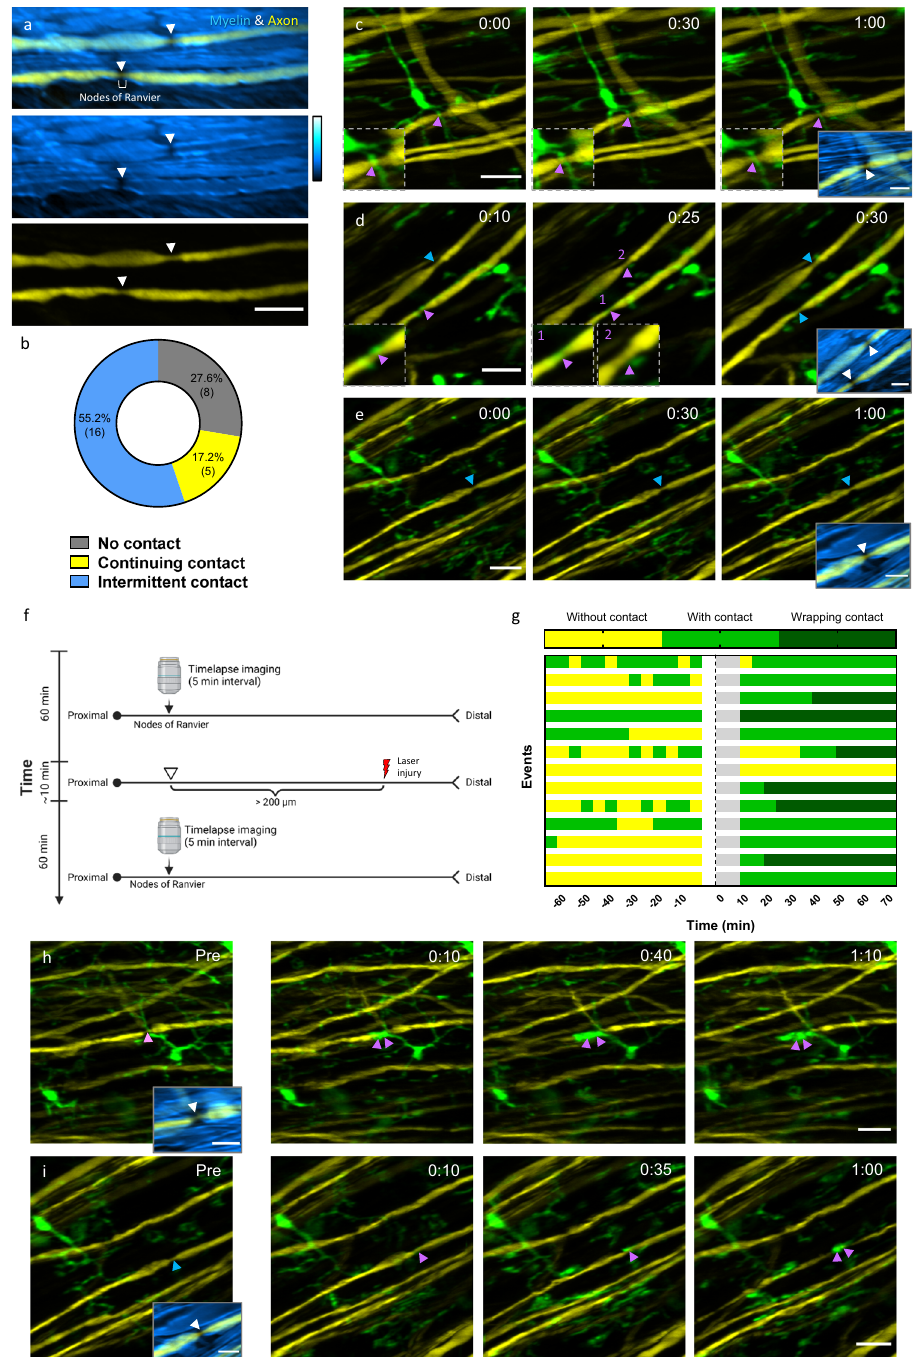
Fig. 5 Dynamic contact between microglia and the nodes of Ranvier. a The overlay of the SRS image of myelin (blue) and the TPEF image of YFP axon (yellow) shows the structure of the nodes of Ranvier. Arrowheads denote the locations of nodes. Scale bar, 20 μ m. b The categorization and statistics of microglial contact with the nodes of Ranvier. Totally 29 nodes from 4 mice were studied. ( c – e ) Representative results of continuing contact ( c ), intermittent contact ( d ) and no contact ( e ) between microglia (green) and the nodes of Ranvier (arrowheads) during 1-hour time-lapse imaging. Insets in the dashed box: zoomed-in fl uorescence images to clearly show the microglia-node contacts. Insets in the solid box, overlay of the SRS image of myelin (blue) and the TPEF image of axons (yellow) showing the position of nodes (white arrowheads). Purple arrowheads indicate nodes with microglial contact, while blue arrowheads indicate nodes with no microglial contact. Scale bar, 20 μ m. ( f ) Illustration of the experimental design. Single-axon laser axotomy was conducted at more than 200 μ m away from the target node of Ranvier to avoid direct laser-induced microglial activation near the nodes. ( g ) Quanti fi cation of microglia-nodes contact before and after laser axotomy. Each bar represents a node of Ranvier. Totally 13 nodes from 4 mice were recorded. The blank and grey areas on the bars denote the time for laser injury and imaging setup when imaging was not performed. Laser injury was performed at time 0. ( h , i ) Representative time sequence images of nodes with wrapped contacts with microglia after axon injury. Before injury, the node in ( h ) has continuing contact with microglia, while the node in ( i ) has no contact with microglia. After injury, wrapping contacts with nodes enveloped by microglia processes are indicated with double purple arrowheads. Time post injury is presented as hr: min. Scale bar, 20 μ m. Insets, overlay of myelin SRS image and axon fl uorescence image. Scale bar for all the insets, 10 μ m. Source data are provided as a Source Data fi le. NATURE COMMUNICATIONS| (2022) 13:1959